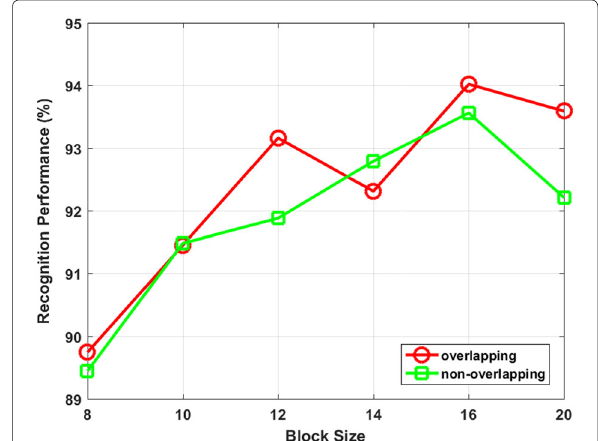
Fig. 5 Impact of the histogram block size on ICANet: Assuming that the length and width of the chunks were equal in the ICANet block histogram stage, and both used overlapping and non-overlapping methods, the block size gradually increased from 8 ∼ 20. The experimental results show that the histogram block size had an impact on ICANet, and the face recognition system had the highest performance when the block size was 16 ×